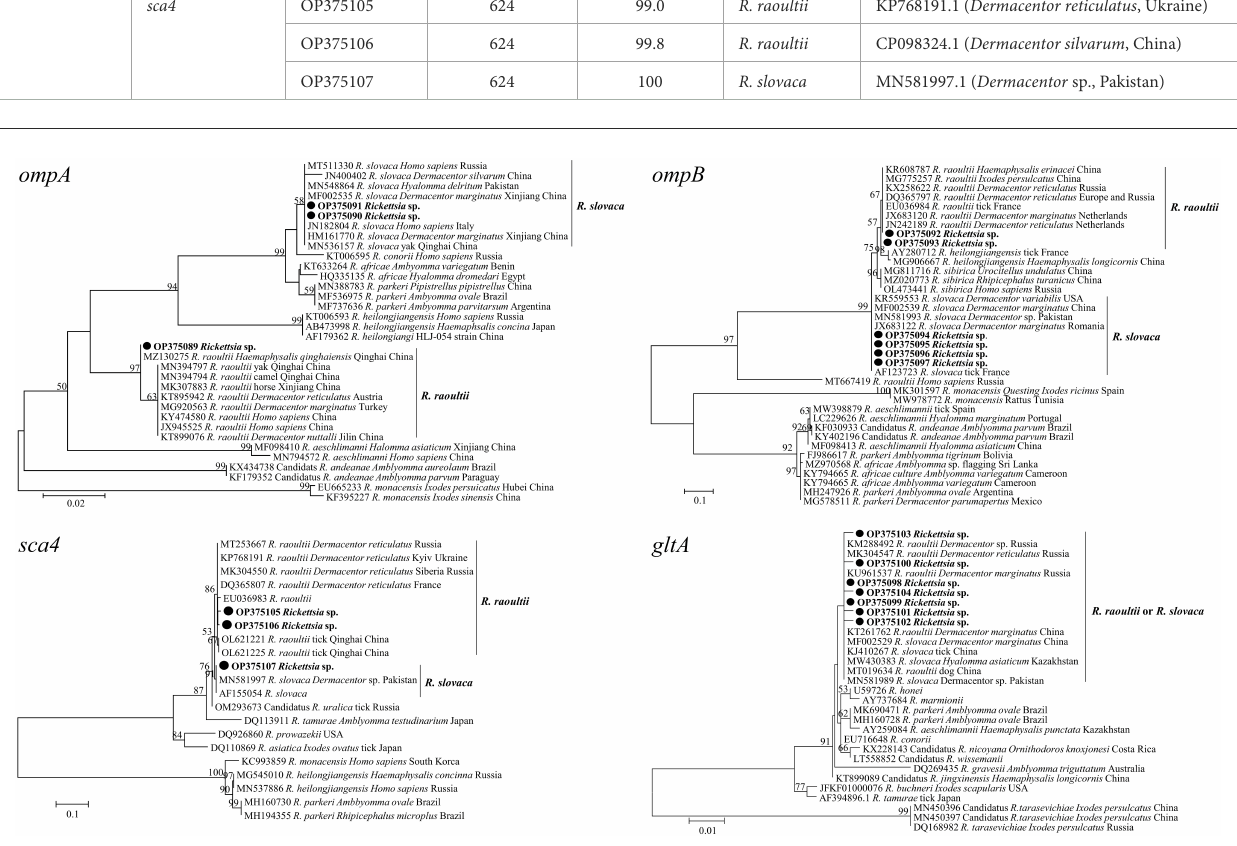
FIGURE5 Molecular Phylogenetic analysis by maximum likelihood method based on the gltA , ompA , ompB, and sca4 genes of spotted fever group Rickettsia . The sequences obtained in this study are shown in bold font. The numbers at the nodes represent bootstrap support